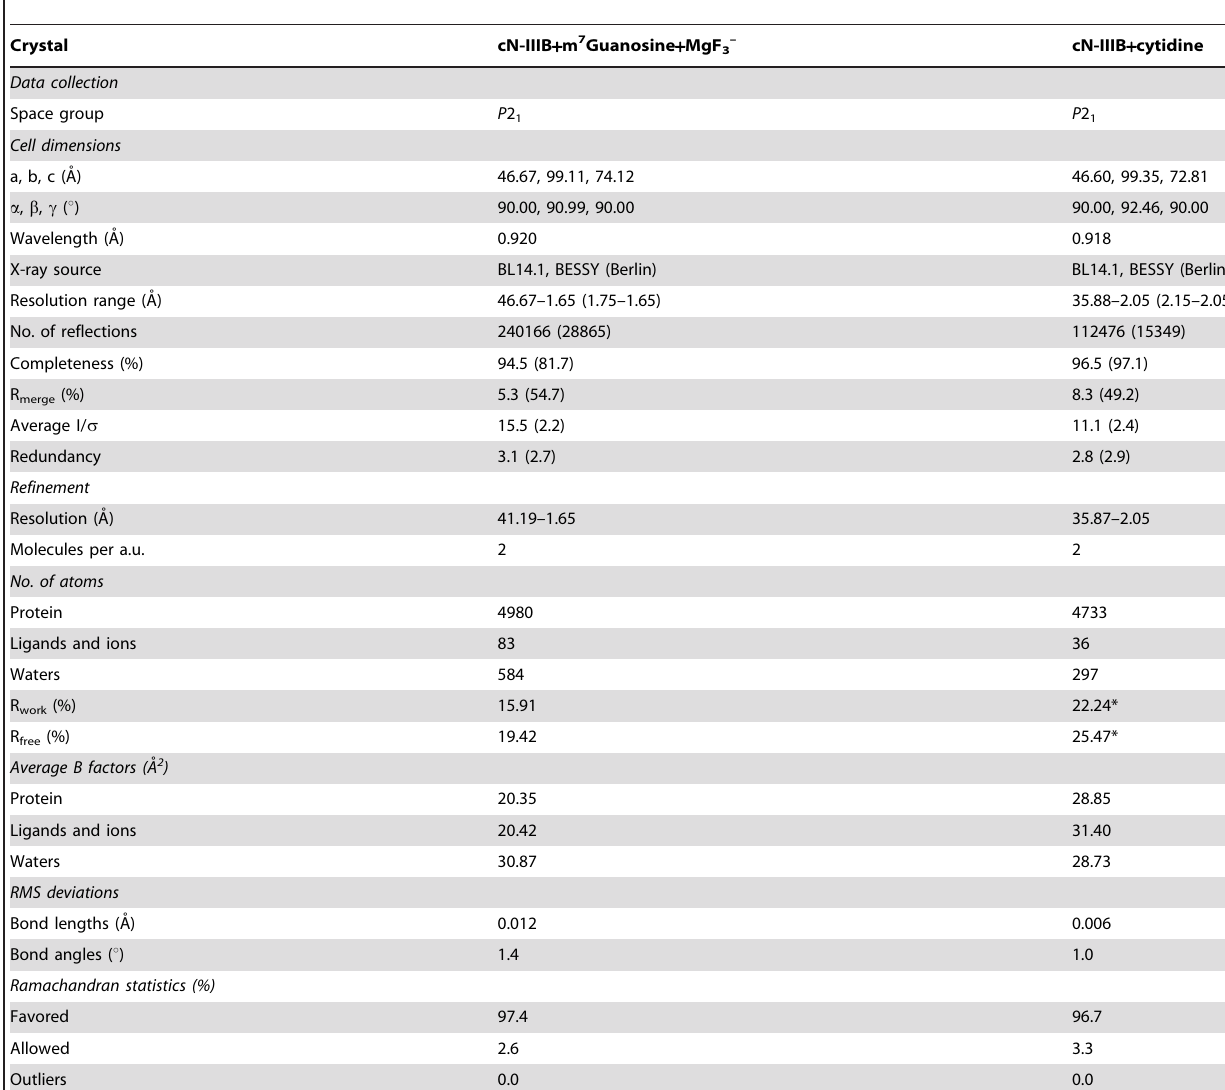
Table 1. X-ray diffraction data and structure refinement statistics of Drosophila melanogaster cN-IIIB bound to different reaction